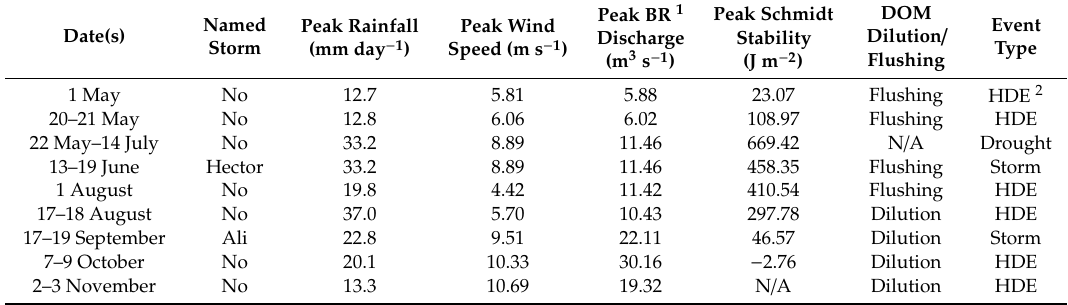
Table 1. Weather events that took place between mid-April and mid-November 2018. Dissolved organic matter (DOM) Dilution / Flushing were defined based on the concentrations of DOM in the Black